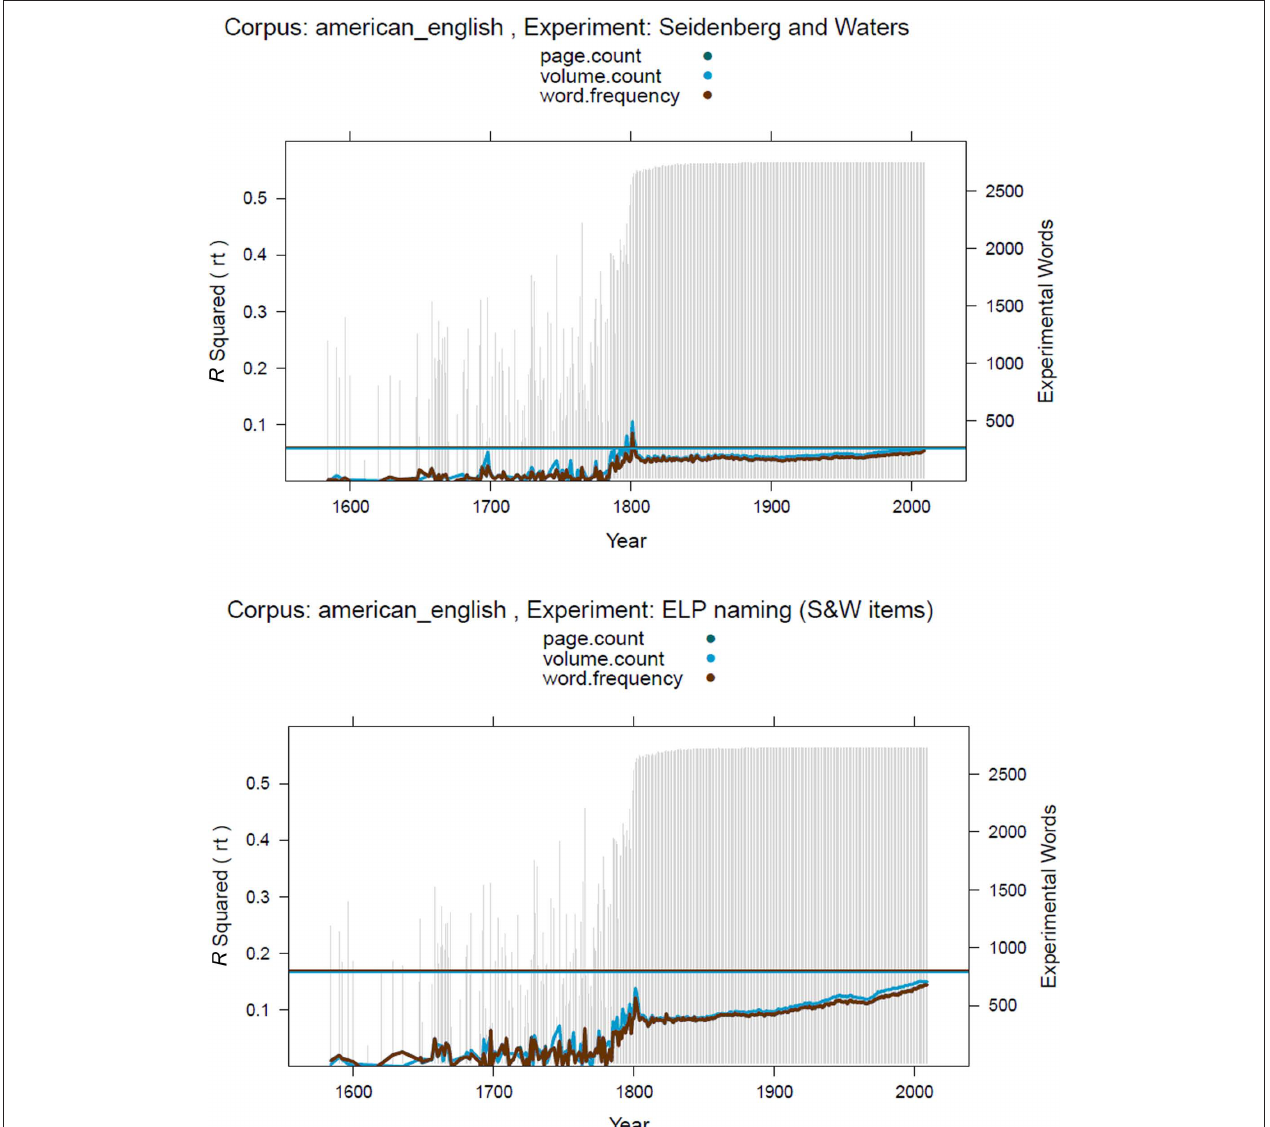
FiGURE 3 | Percentages of variance explained by the Google American English ngrams in the naming latencies of the Seidenberg and Waters (1989) word naming study (top) and the Balota et al. (2007) replication (bottom). Horizontal lines: Percentages of variance explained by SUBTLEX-US. The patterns are similar for the English Fiction